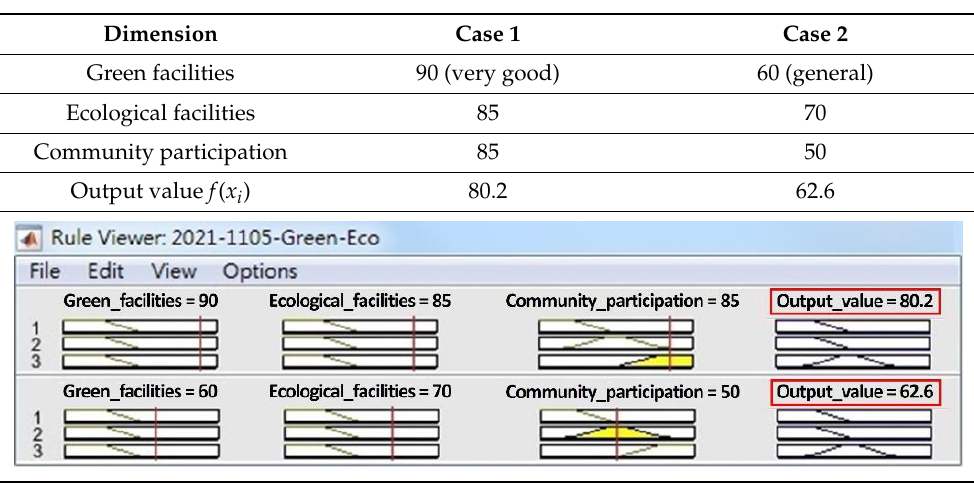
Table 10. Output values of each dimension of the residential houses (cases 1 and 2) from the DAFuzzy model.